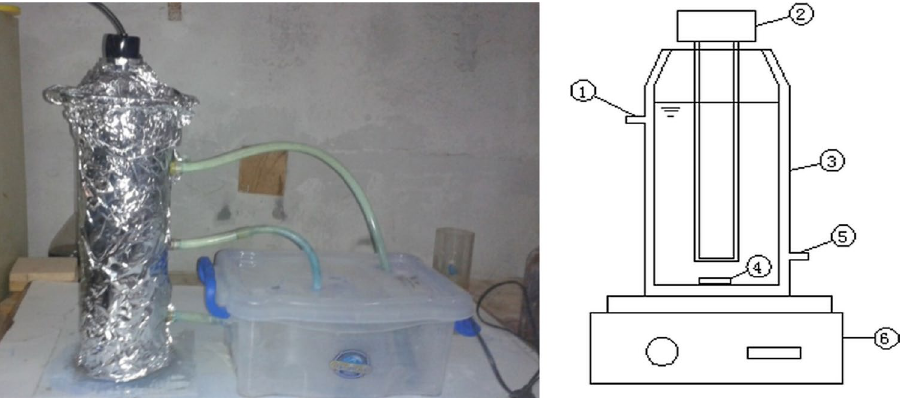
Figure 1. Reactor of UV-based advanced oxidation process: (1) Cooling water out, (2) UV Lamp, (3) Reactor, (4) Stirrer, (5) Cooling water in, and (6) Magnetic